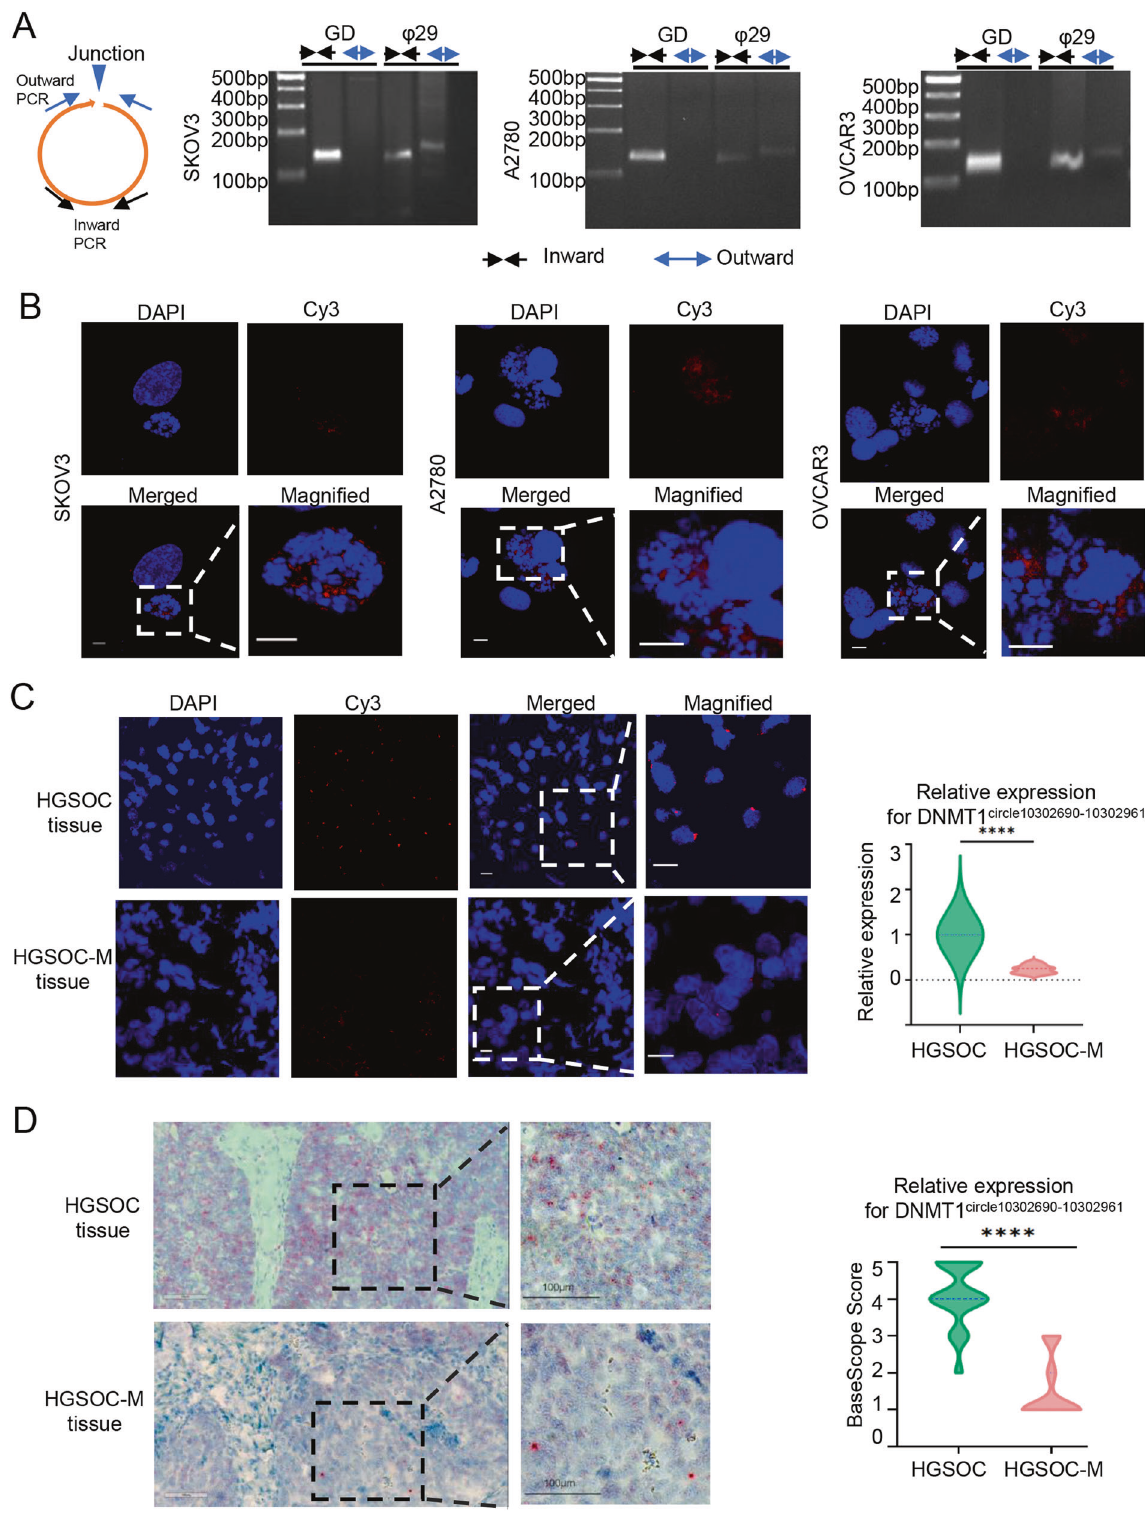
Fig. 5 DNMT1 circle10302690-10302961 is down-regulated in metastatic tumors compared to primary tumors of HGSOC. A Outward PCR (blue arrow) and inward PCR (black arrow) in genomic DNA (GD) and phi29-ampli fi ed eccDNA ( φ 29) samples to validate the speci fi c junction of DNMT1 circle10302690-10302961 in SKOV3, A2780, and OVCAR3 cells. B FISH assays of metaphase SKOV3, A2780, and OVCAR3 cells. The probe targeting the junction of DNMT1 circle10302690-10302961 was labeled by Cy3. C The representative images of FISH assays of DNMT1 circle10302690-10302961 in paired primary (upper) and metastatic tissues (lower) of HGSOC patients. D The representative images of BaseScope assays of DNMT1 circle10302690-10302961 in paired primary (upper) and metastatic tissues (lower) of HGSOC patients. DNMT1 circle10302690-10302961 appeared as distinct red dots, with each dot representing a single eccDNA molecule. The data were presented as mean ±SD; **** P <0.0001.